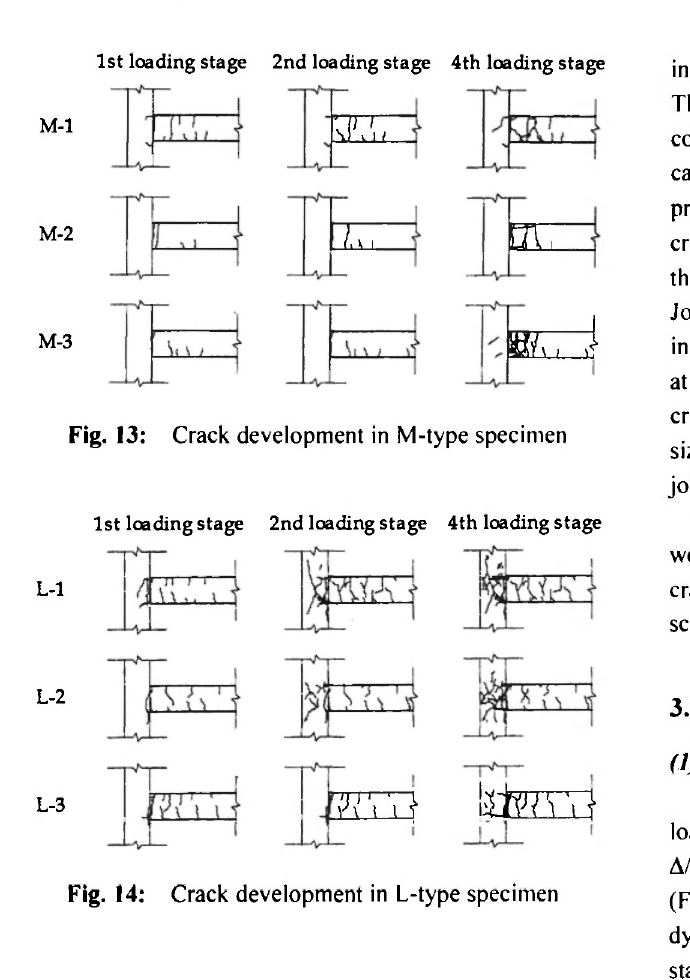
Fig. 14: Crack development in L-type